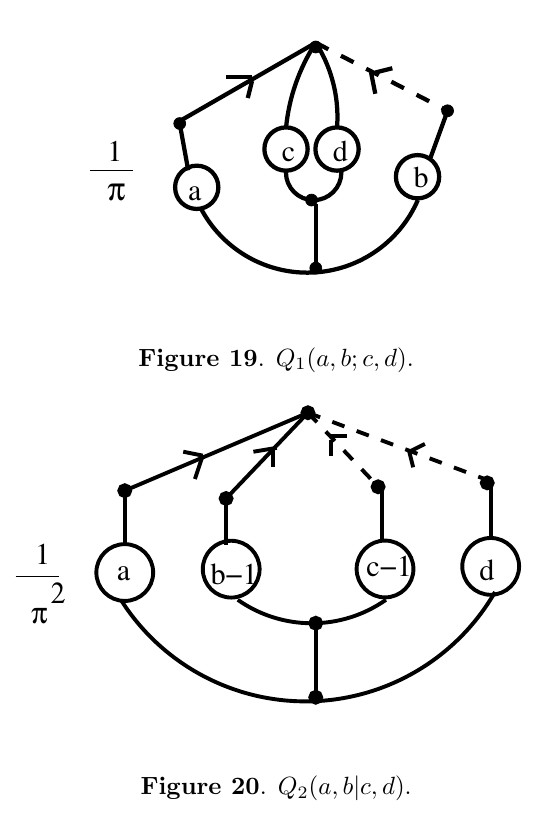
Figure 20 . Q 2 ( a; b j c; d